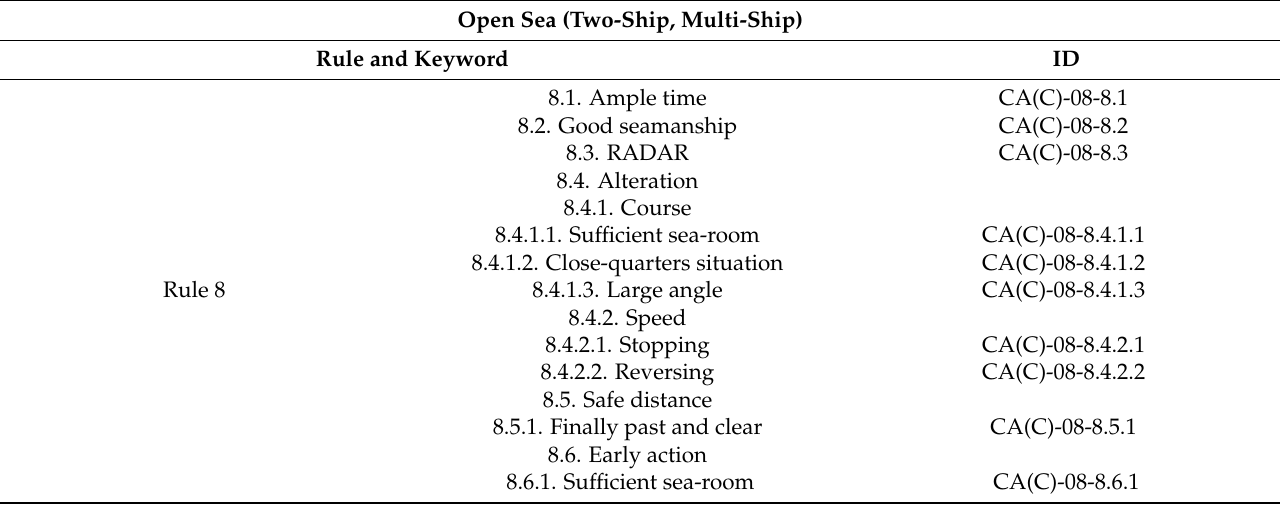
Table A8. Requirements specifications for collision avoidance action